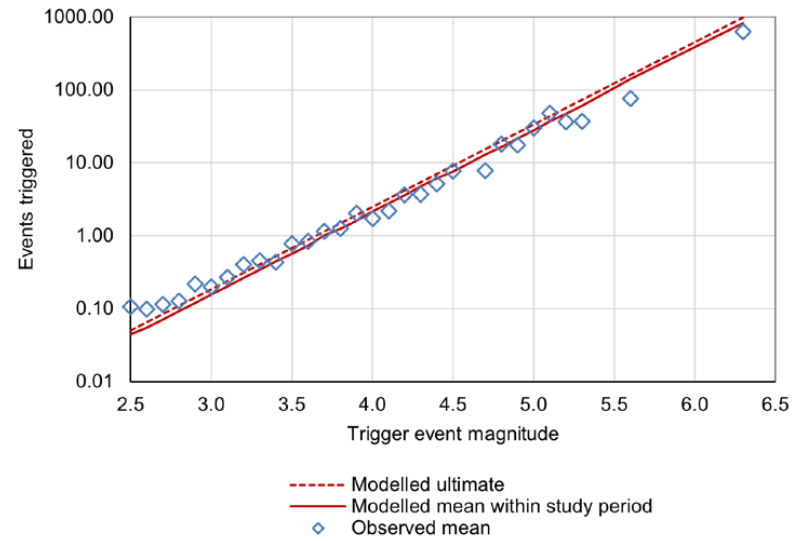
Figure 10. Results of the triggering ability test: comparison of modelled and observed triggered event numbers by trigger event magnitude. numbers by trigger event